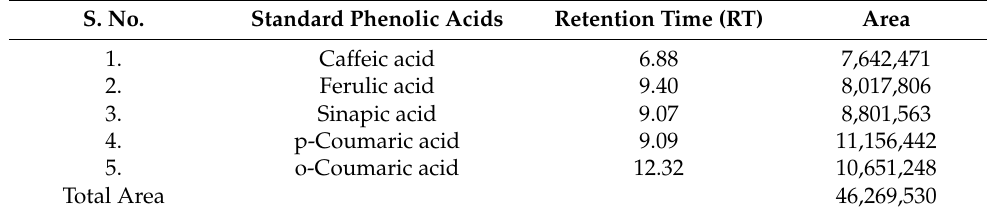
Table 8. Standard phenolic acids retention time (RT) and peak